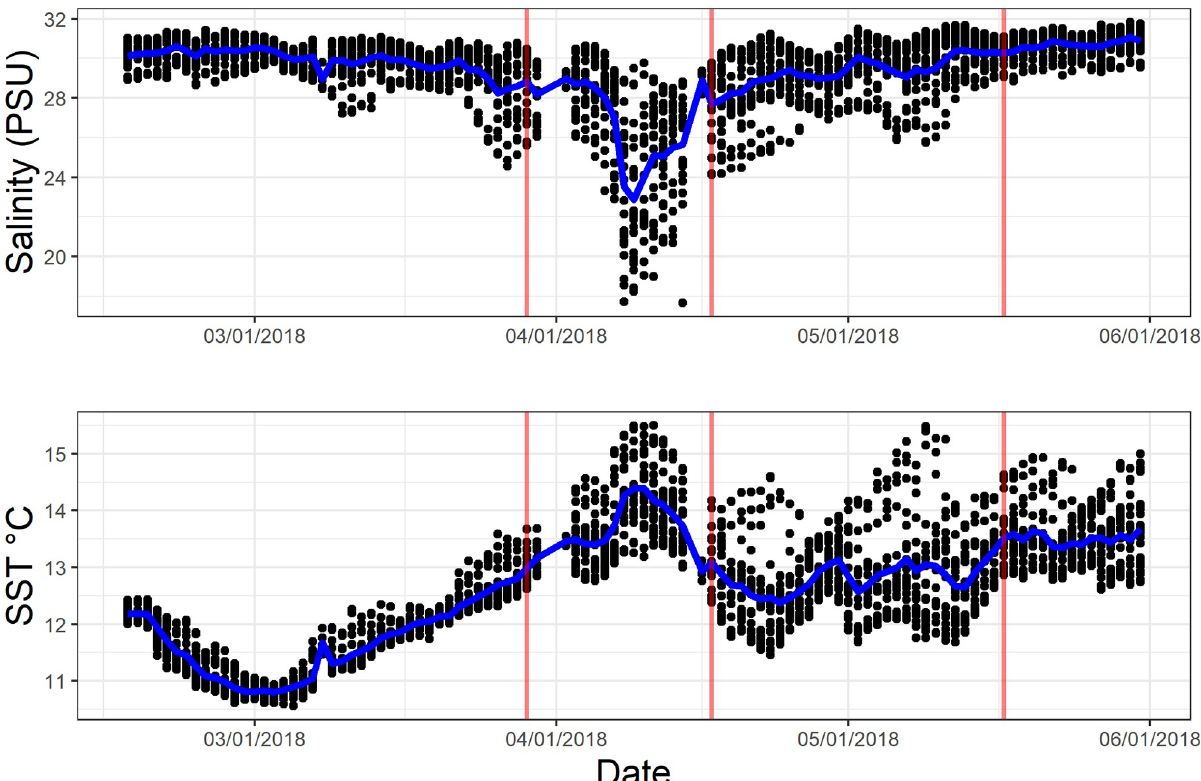
Fig 3. Salinity and temperature measurements at the Fort Point buoy during the survey period. Black dots show individual sampling measurements, the blue line shows daily average. Anemone sampling dates at Point Bonita are shown as red lines. One major freshwater outflow event occurred during the sampling period along with multiple minor events. Sea surface temperature (SST) was not as high as documented in past low salinity events. The most extreme low salinity period was roughly 10 days, longer than many outflow events in the past. Salinity at the Fort Point Buoy is measured and reported in PSU, equivalent to parts per thousand (ppt) reported in our experimental